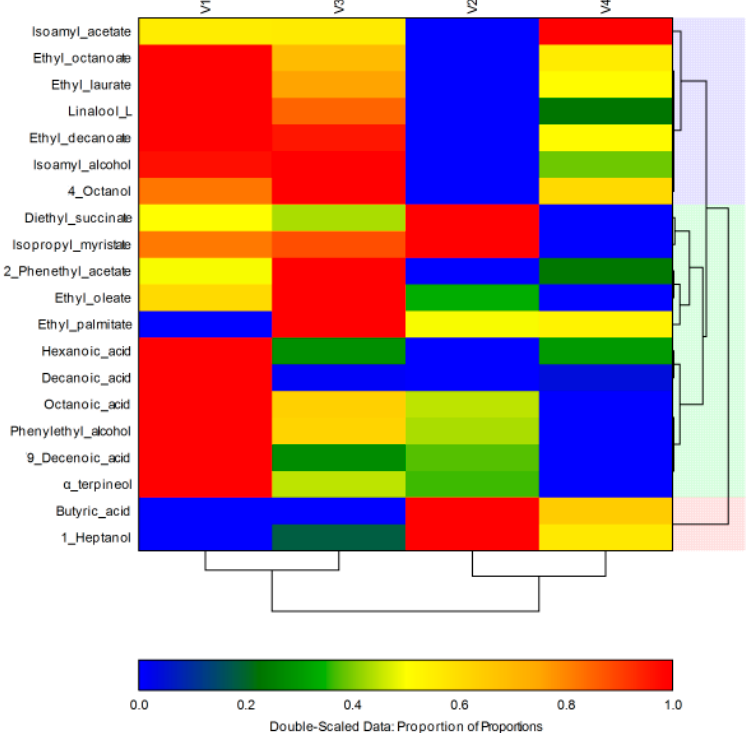
Figure 2. Heat map obtained using the concentration of each volatile compound in resulted experimental sparkling wines. Clusters linked to the grouping of volatiles and samples were designed. Samples represented with blue color showed the lowest concentrations of the separated compound, while the highest levels are represented in red.